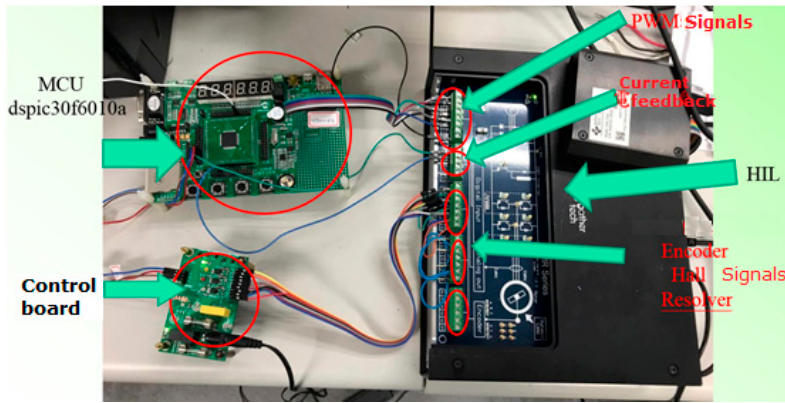
Figure 10. Torque–speed curves by fixed torque angle method and fuzzy MTPA/MTPV control.